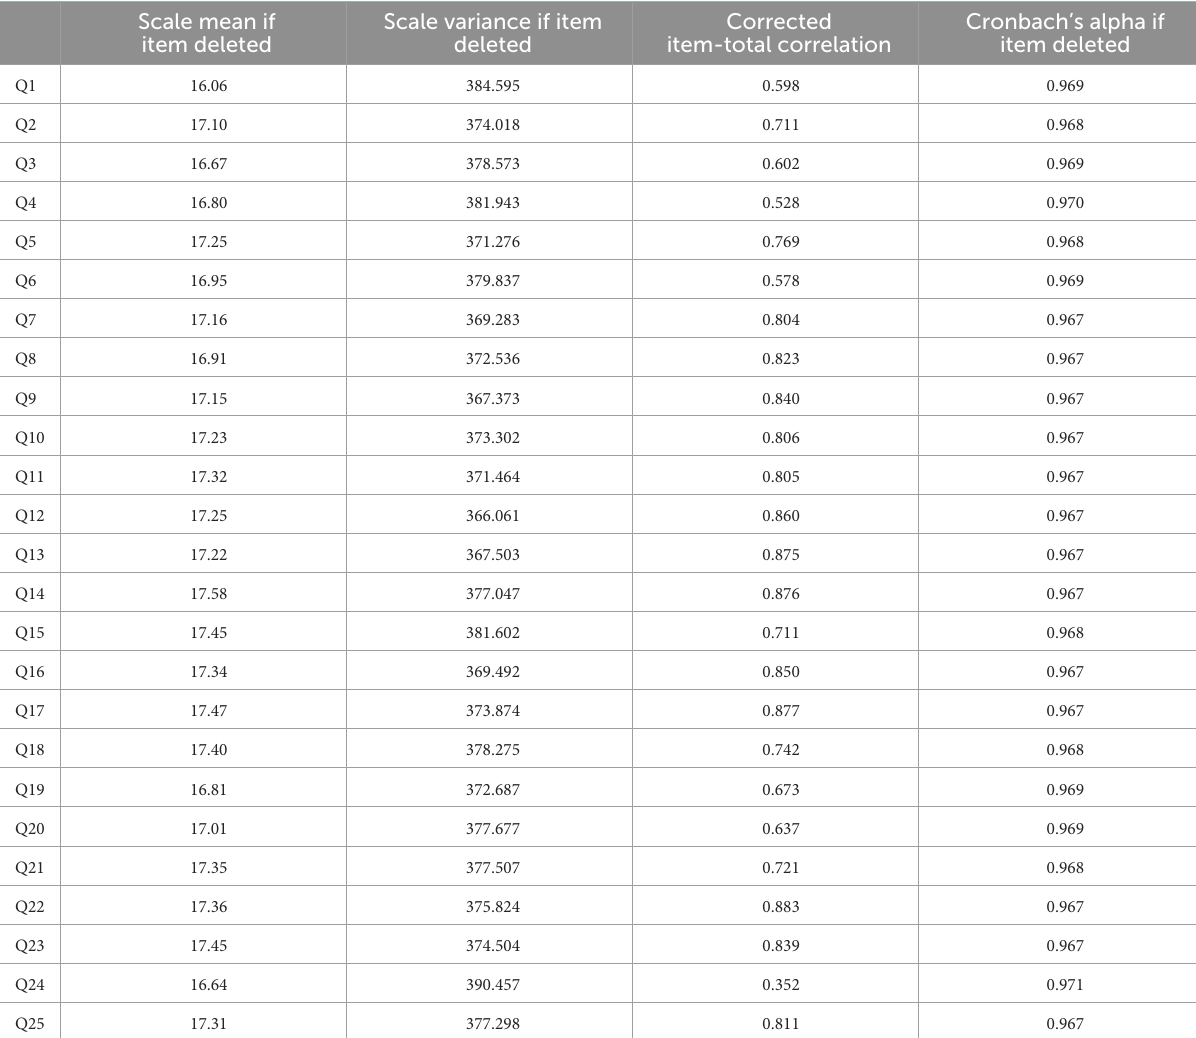
TABLE 5 Internal consistency of the Indonesian version of